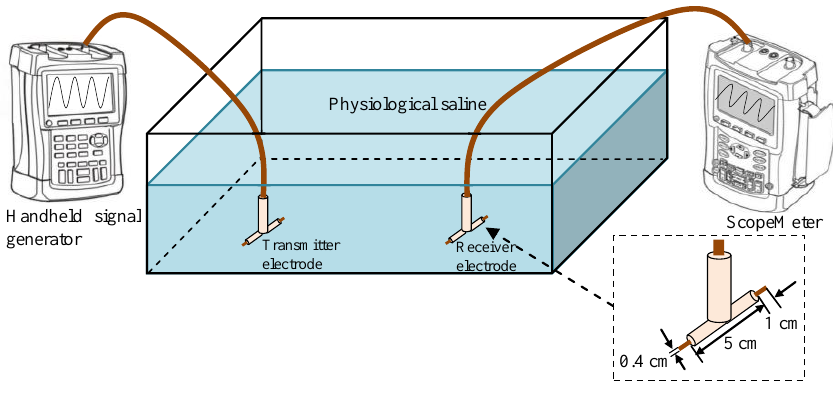
Figure 7. Measurement setup of implant IBC based on galvanic